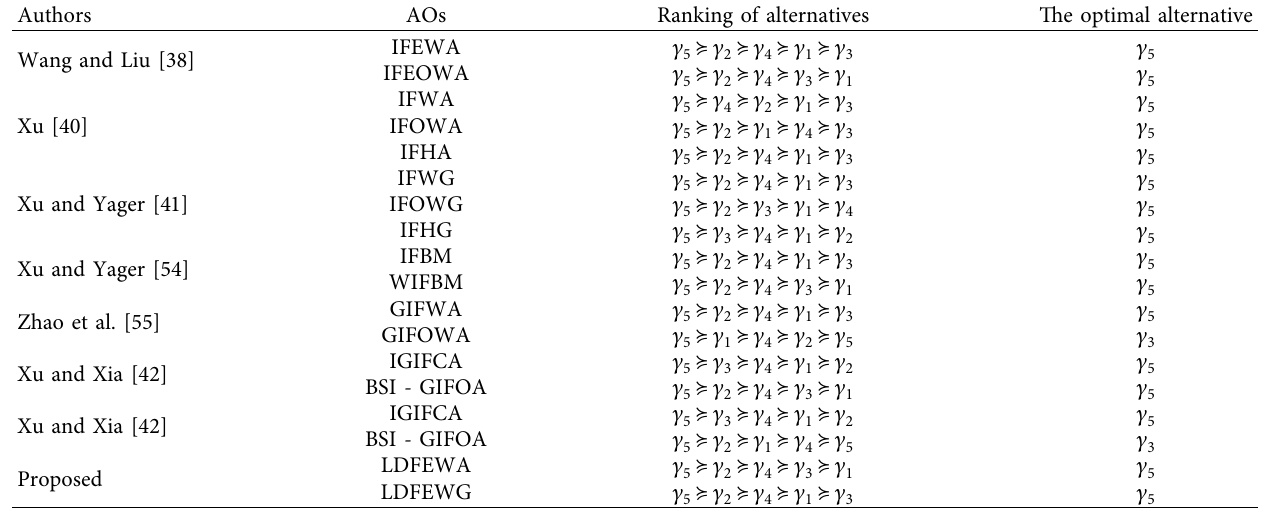
Table 10: Comparison of proposed operators with some exiting